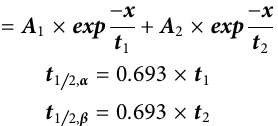
Frontiers in Pharmacology |